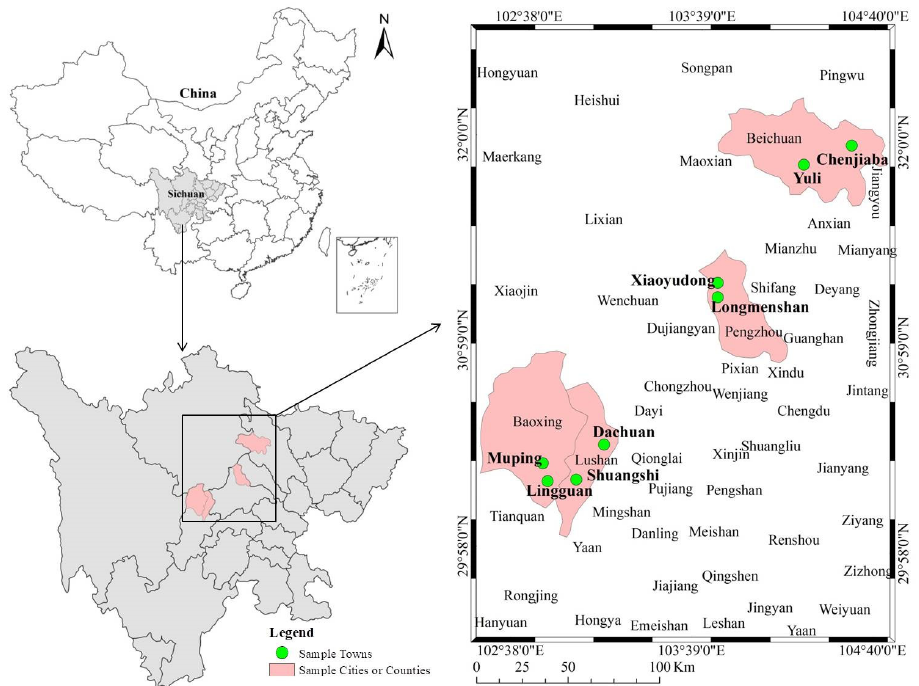
Figure 1. Location map of sample counties and towns.